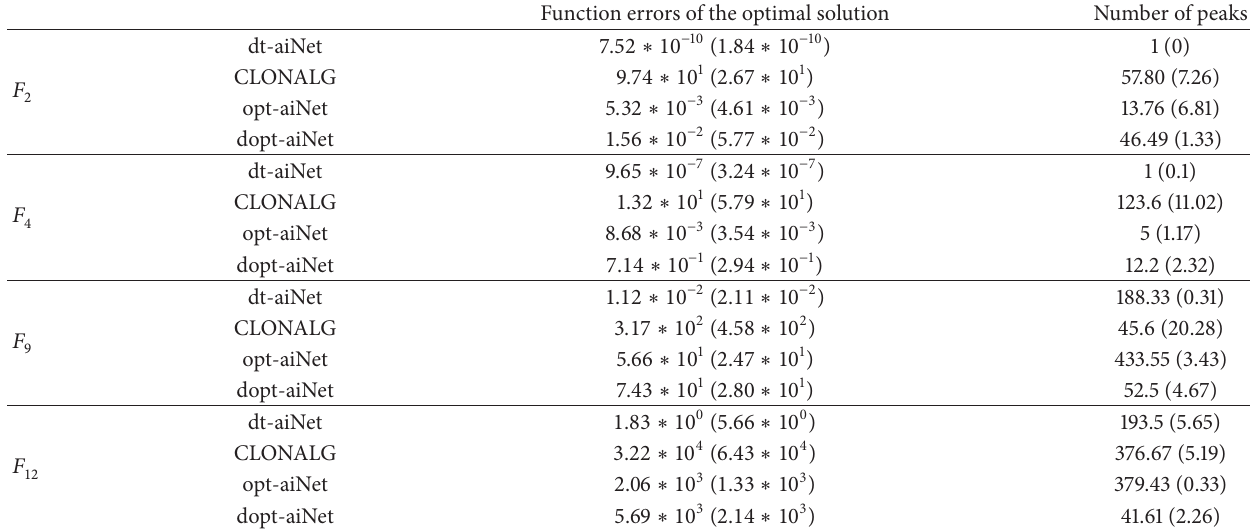
Table 5: Results (errors) in 10-dimensional spaces.